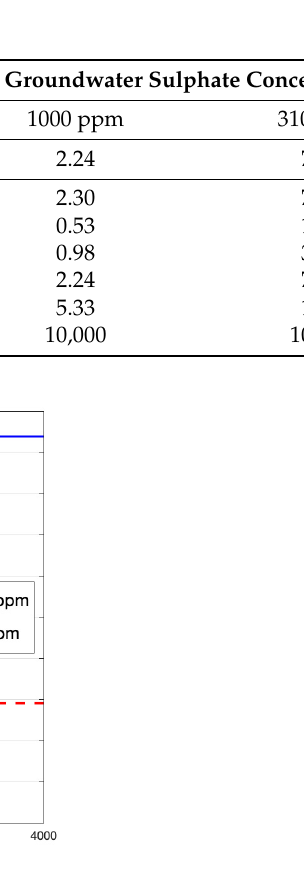
Figure 2. Sulphide concentration and flux to UFC for Scenario I.